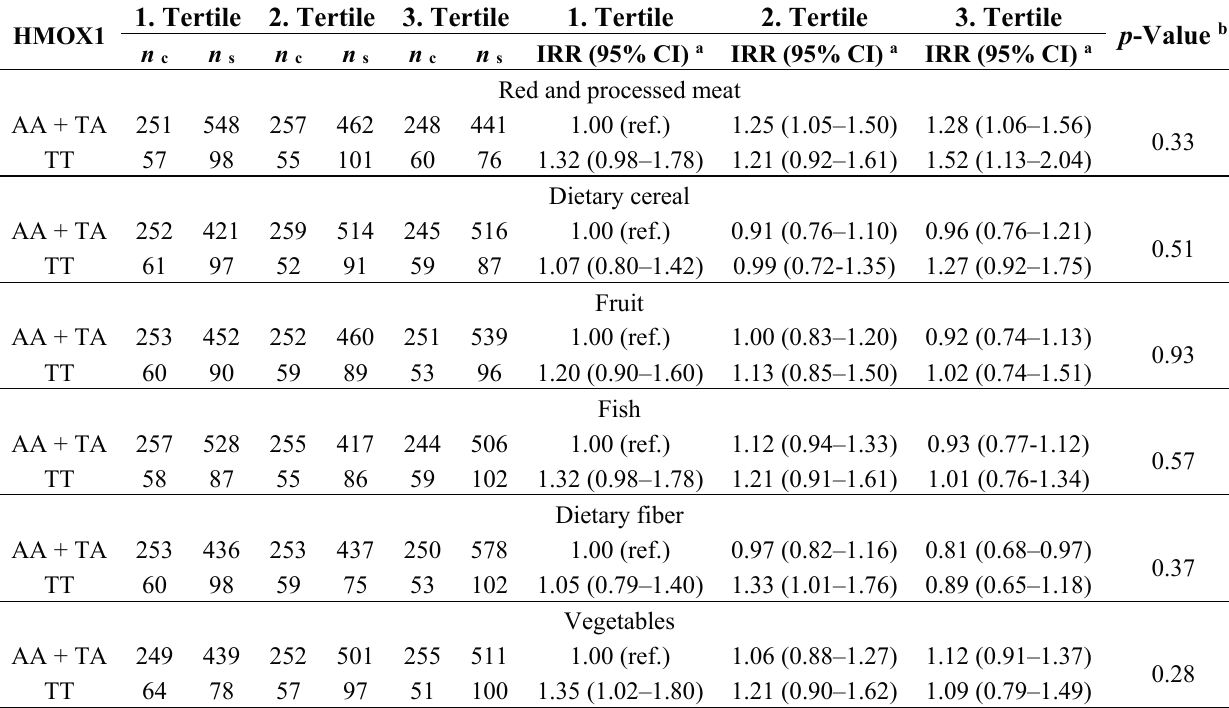
Table 4. IRR for colorectal cancer for tertiles of intake of dietary factors for HMOX1 A-413T